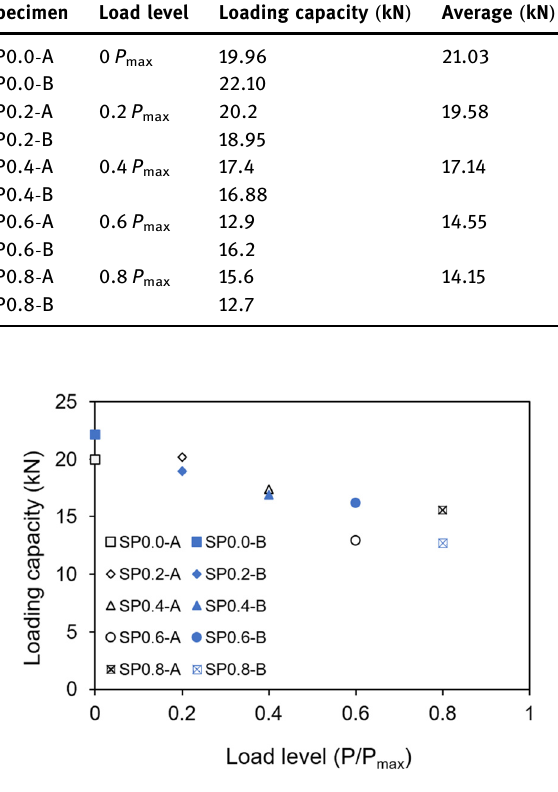
Figure 8: Loading capacity of beams.